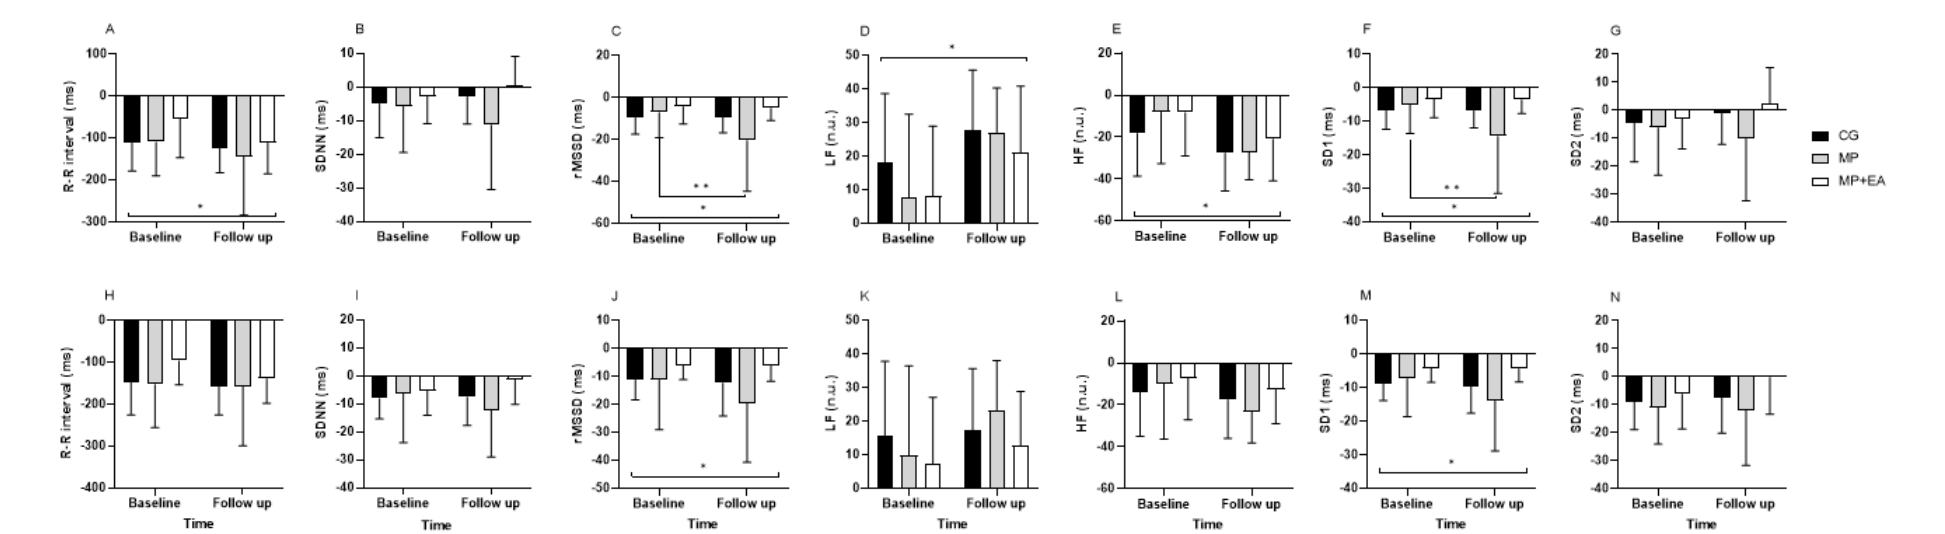
Figure 2. Comparisons for heart rate variability indices considering the delta of Stand and Supine and Stand and Recovery (Standing minus Recovery) for heart rate variability indices, excluding participants who used beta-blockers (N = 41). ( A – G ) Delta of Stand and Supine (Standing minus Supine), and ( H – N ) Stand and Recovery (Standing minus Recovery). CG: Control Group; MP: Mat Pilates Group; PM+AE: Mat Pilates Supplemented with Aerobic Exercise Group. R-R interval: the average of all normal R-R intervals; SDNN: standard deviation of R-R intervals; rMSSD: the square root of the mean squared differences in successive R-R intervals; LF: low-frequency band; HF: high-frequency band; SD1: variance of R-R intervals in a short time scale; SD2: variance of R-R intervals in a long time scale. * Indicates within-group effect ( p < 0.05). ** Indicates MP group difference ( p < 0.05).